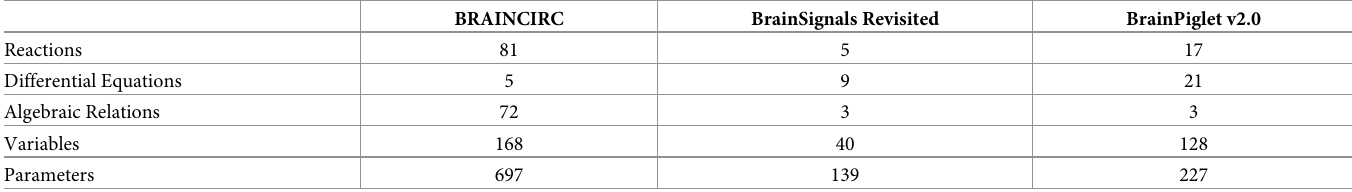
Table 1. Comparison of the number of reactions, equations, relations, reactions, variables and parameters in the BRAINCIRC, BrainSignals Revisited and BrainPig- let v2.0